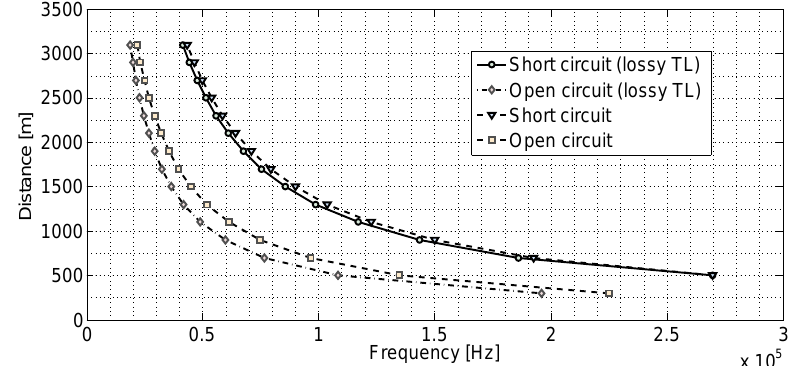
Figure 9. Distance from the failure obtained at the frequency of the first null of the amplitude